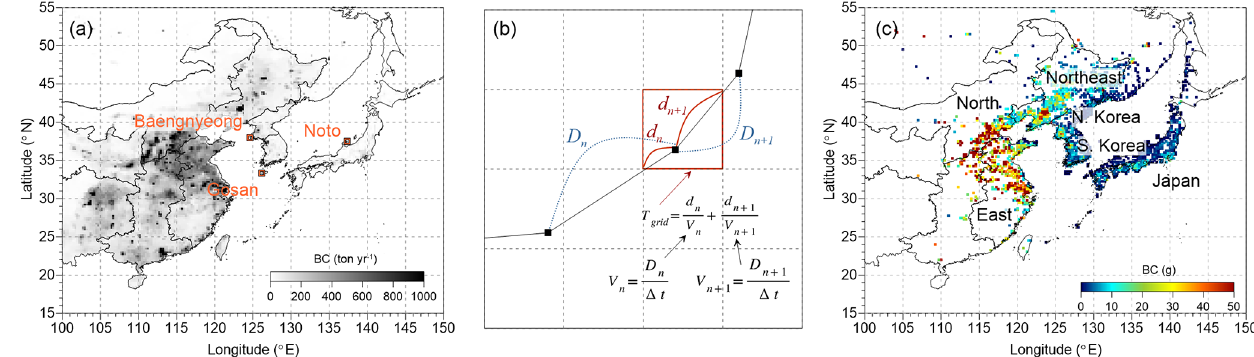
Figure 1. (a) The location of the three measurement sites (Baengnyeong, Gosan, and Noto) and the black carbon (BC) emission rate (tyr − 1 ) over East Asia from the Regional Emission inventory in ASia (REAS) version 2.1 (Kurokawa et al., 2013). (b) Illustration of residence time calculated based on the HYSPLIT backward trajectory that passed over a single grid cell (see details in the text). (c) The location of administrative districts, and the spatial distribution of the mean BC mass in the potential emission region, which is the highest BC mass grid of each trajectory. The BC mass was obtained by multiplying (a) the emission rates and (b) the residence